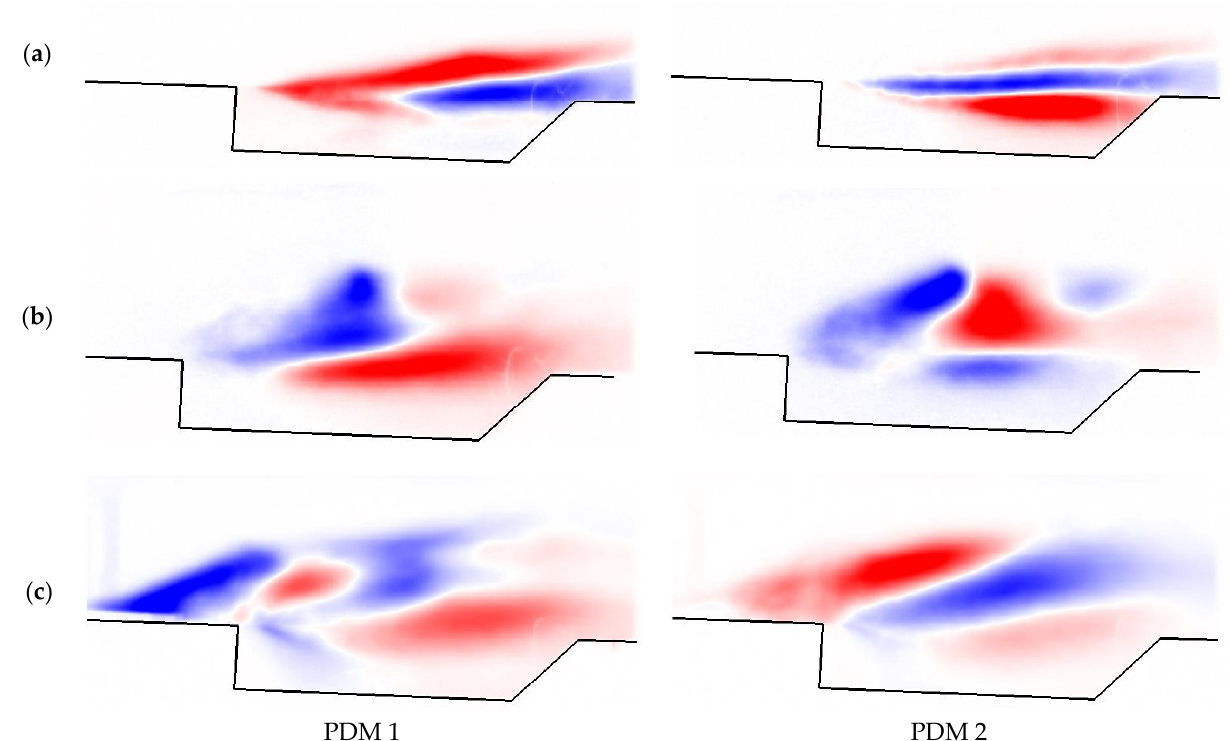
Figure 6. The first two PDMs of flame CH* chemiluminescence. ( a ) φ = 0 .1, ( b ) φ = 0 .15, ( c ) φ = 0 .2. The power spectral density (PSD) for the time coefficient was obtained using the fast PSD spectrum of PDM 0, 1, and 2 for φ = 0.10, 0.15, and 0.20. With the combustion